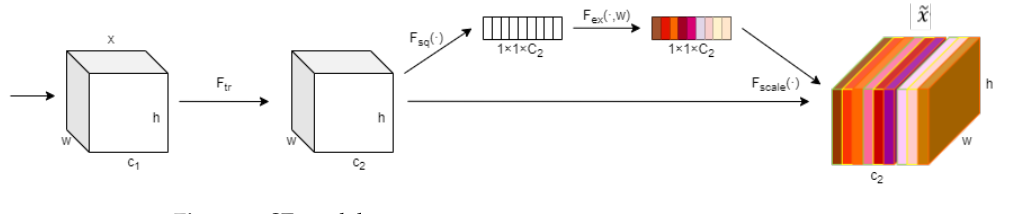
Figure 2. SE model.